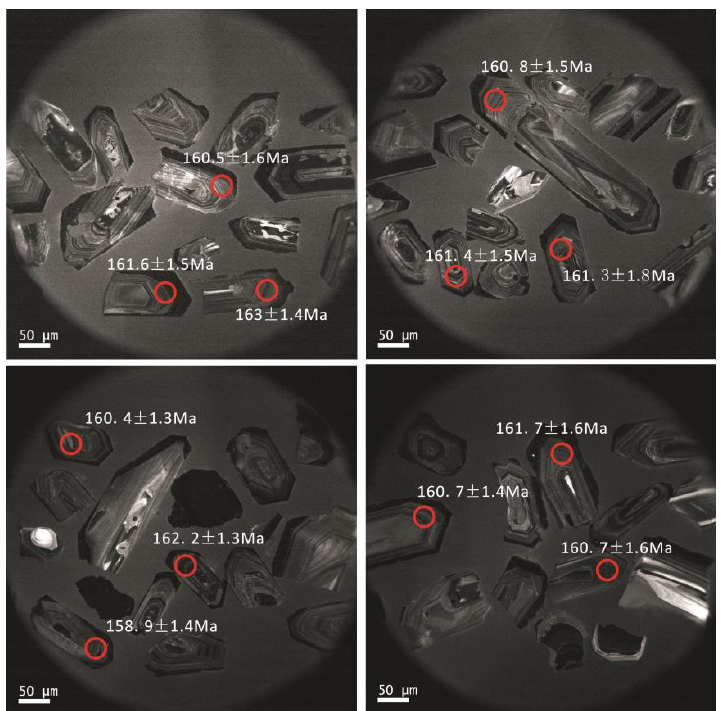
Figure 7. CL images of selected dated zircons from fine-grained biotite granite. The red circles and nearby numbers indicate the spot locations and concordant ages.